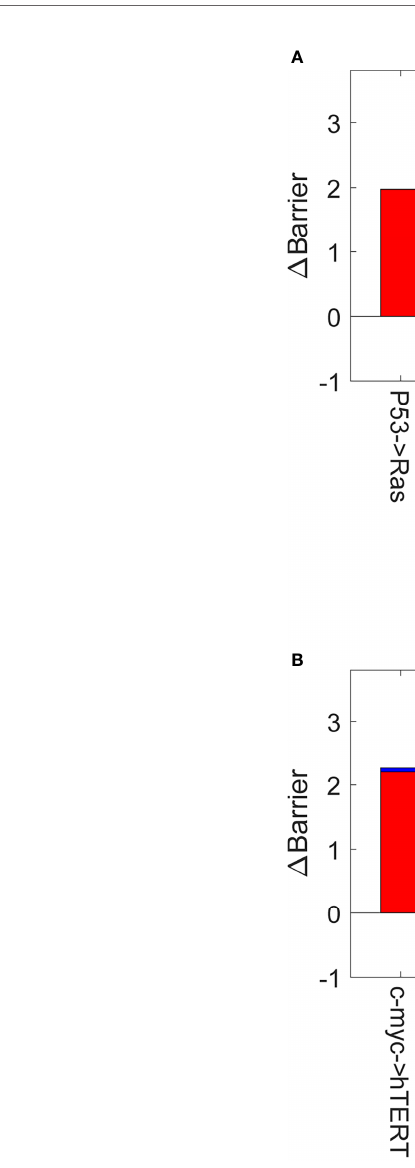
FIGURE 4 | The global sensitivity analysis for IGC. The X-axis represents the top 10 most sensitive regulations, and the Y-axis represents variations in the barrier height ( Δ Barrier). (A) The variations in the barrier height between the normal and AG states. Δ Ung is the variation in the barrier height between the normal and AG states. Δ Ugn is the variation in the barrier height between the AG and normal states. (B) The variations in the barrier height between the AG and cancer states. Δ Ugc is the variation in the barrier height between the AG and cancer states. Δ Ucg is the variation in the barrier height between the cancer and AG